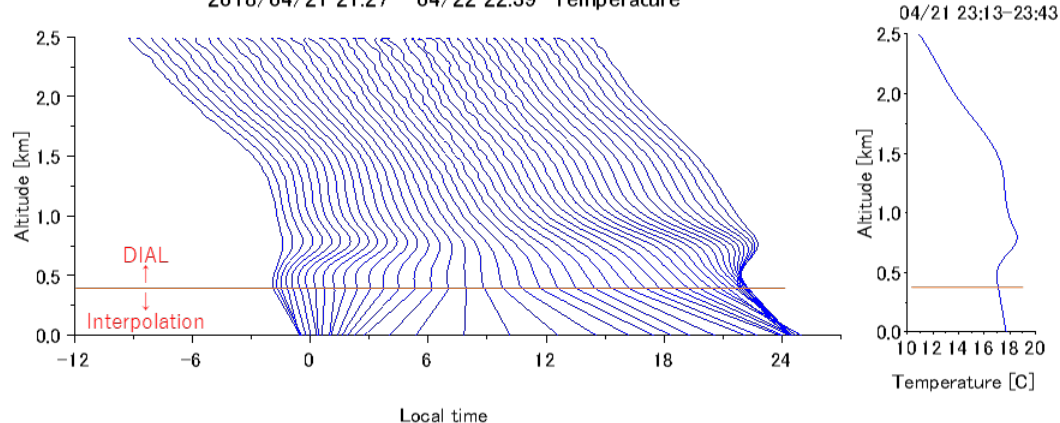
Figure 1 Atmospheric temperature profiles with an integration time of 30 minutes obtained from three wavelength CO 2 DIAL on 21-22 April